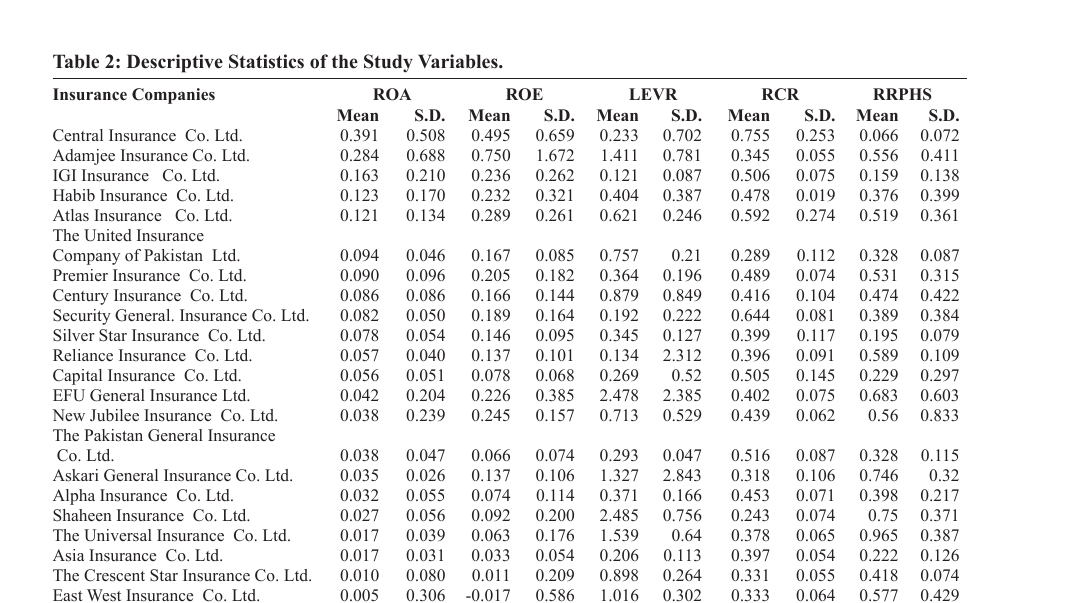
Table 2: Descriptive Statistics of the Study Variables. Insurance Companies ROA ROE LEVR RCR